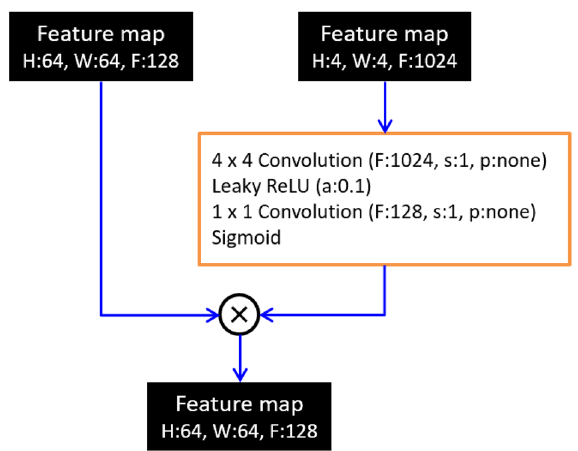
Figure 2. Skip-layer excitation module used in the generator. Symbols H, W and F in feature maps denote height, width and channels, respectively. Symbols s, p and a denote strides, padding and slope of Leaky ReLU activation function, respectively. For padding, “none” indicates that no padding is applied to the input feature